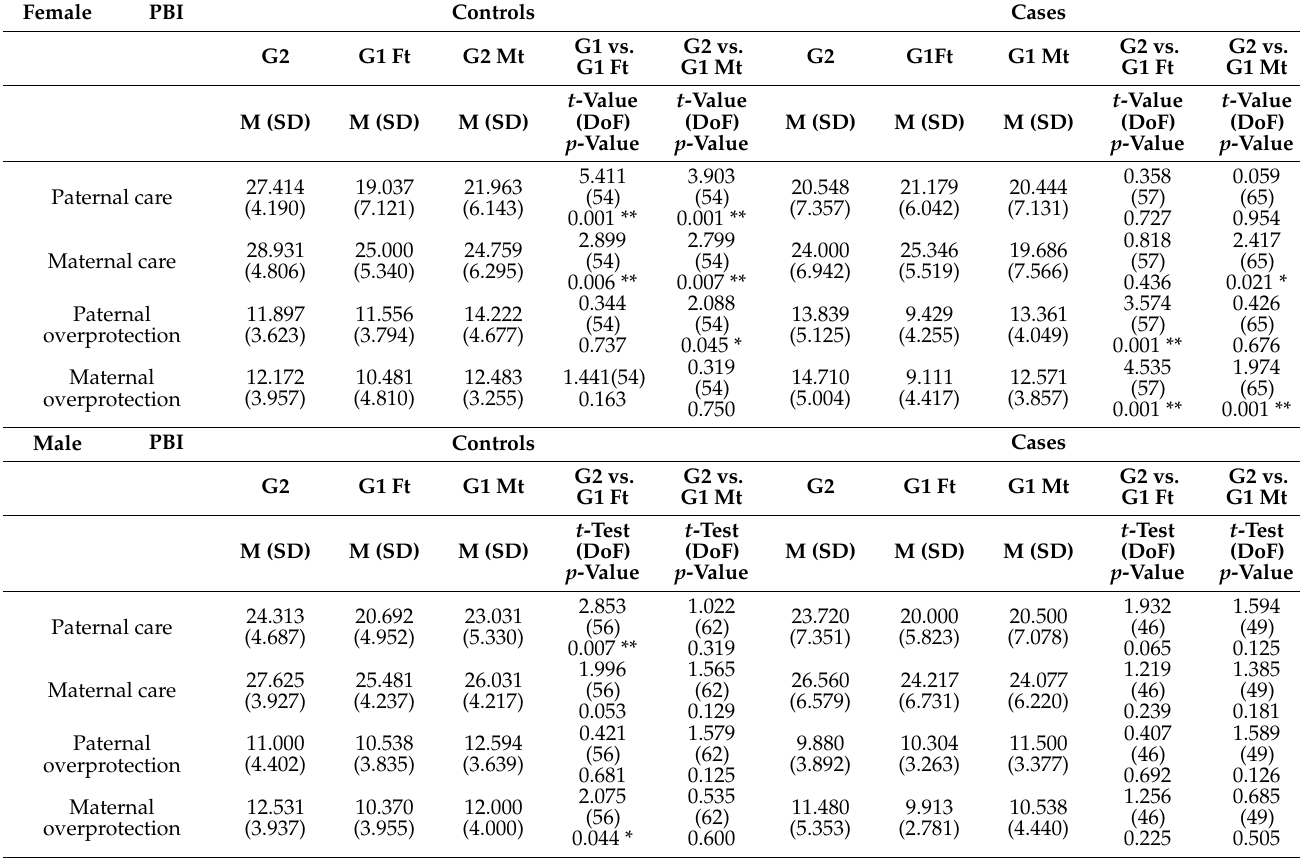
Table 7. Female/males: t -test G2 vs.